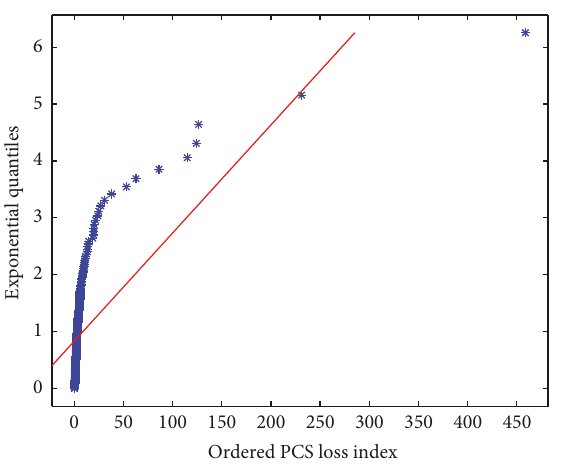
Figure 8: Exponential QQ-plot of the PCS loss index from 2001 to 2010.